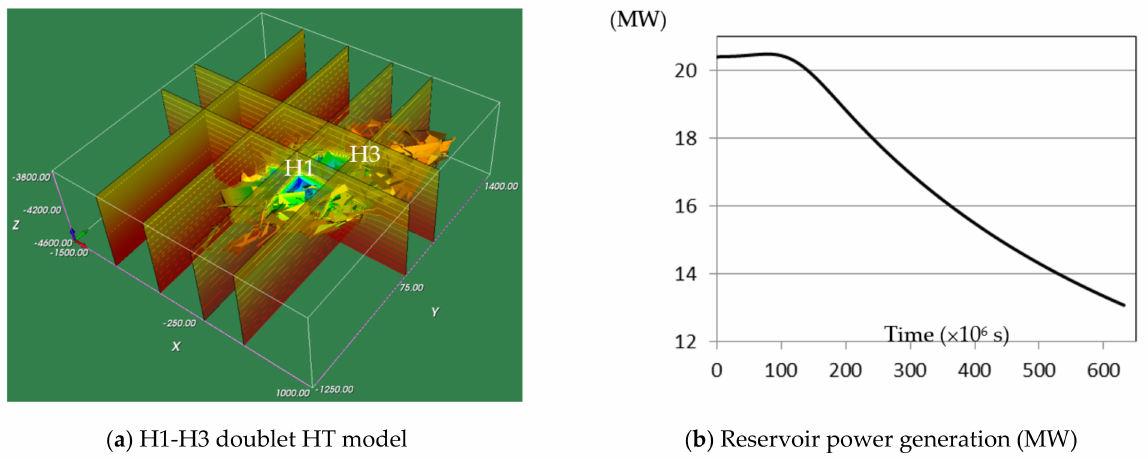
Figure 20. Reservoir HT model ( a ) and power generation from the reservoir ( b